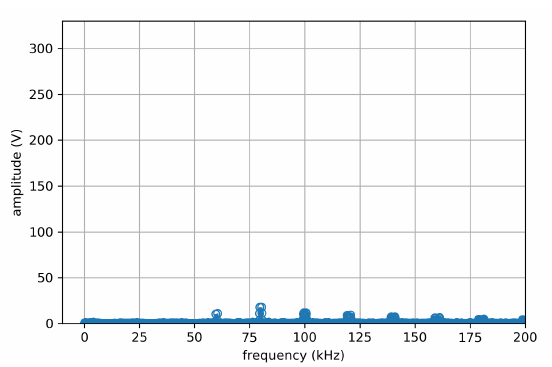
Figure 15. Difference of the spectrum of the inverter simulation with 28 harmonics compared to Simulink EMT.